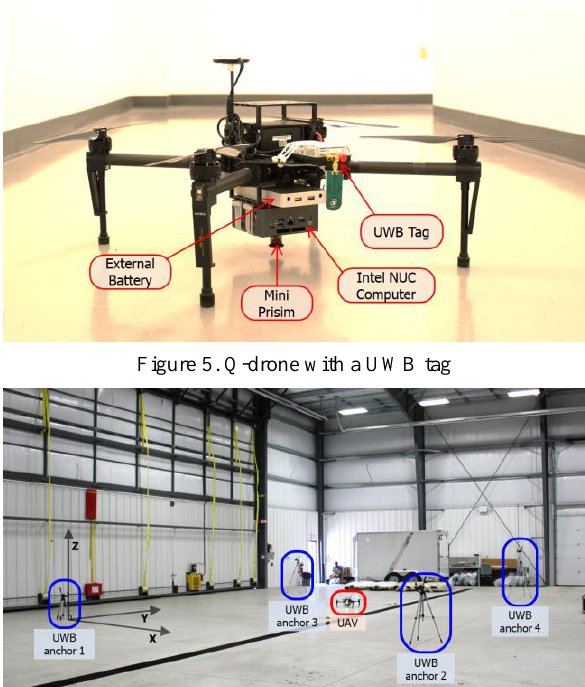
Figure 6. Experimental setup, showing the configuration of UWB